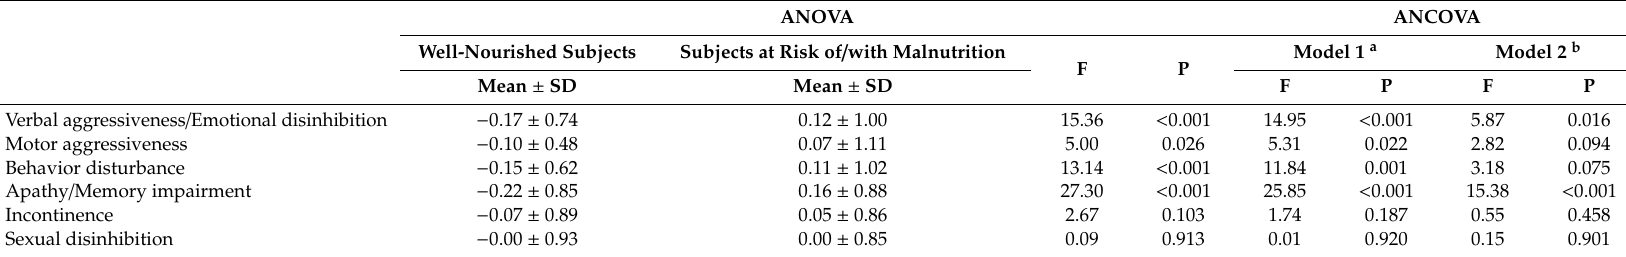
Table 4. The association between nutritional status and factor scores of Dementia Behavior Disturbance Scale in subjects with MCI and early-stage AD according to ANOVA and ANCOVA.